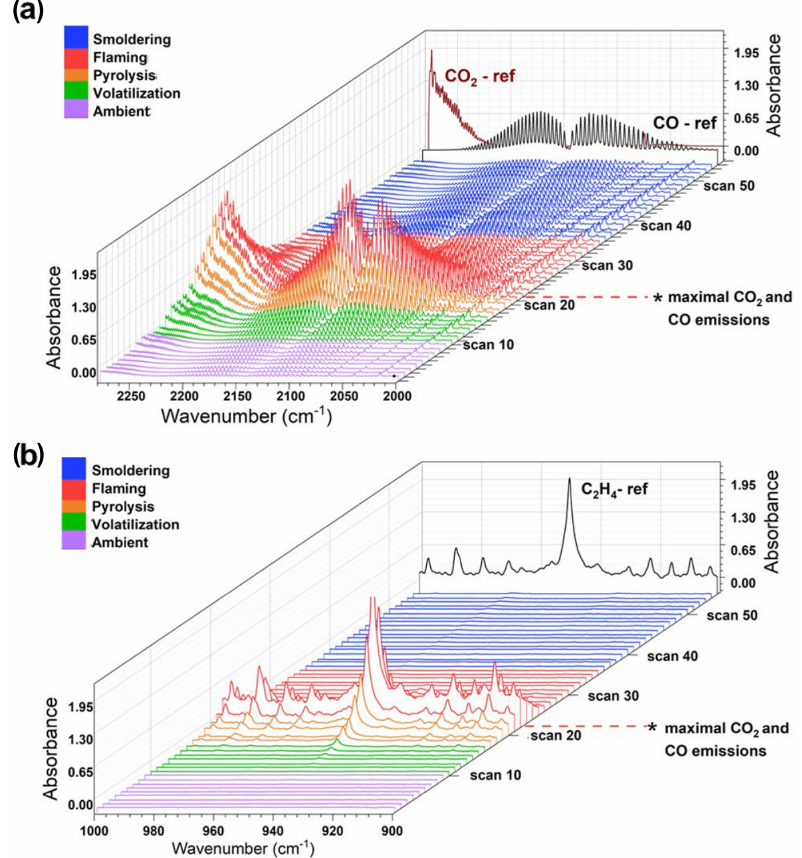
Figure 4. Burn 87 with inkberry and longleaf pine needles: (a) CO and CO 2 spectral profile from 2250–2000cm − 1 . Purple traces indicate the ambient stage, green and orange traces indicate the pre-combustion and pyrolysis stage, red spectral traces indicate the flaming stage, and blue traces indicate smoldering. (b) Largely C 2 H 4 spectral waterfall plot from 1000–900cm − 1 with accompanying C 2 H 4 reference spectrum as a black